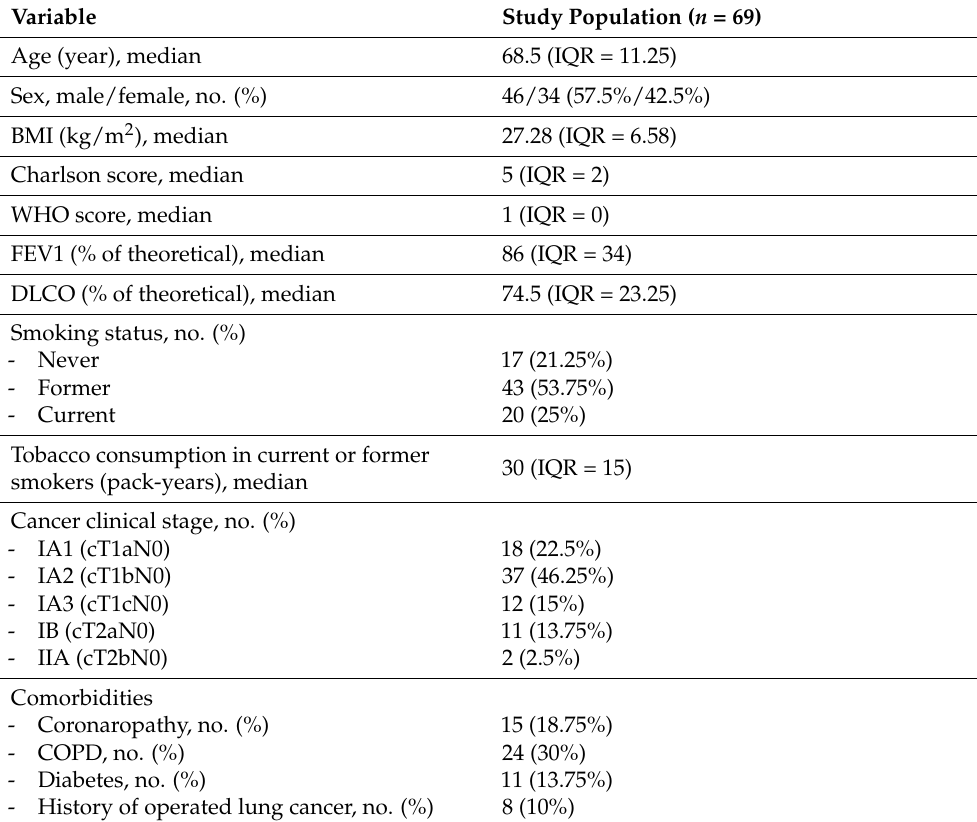
Table 1. Patients’ characteristics.